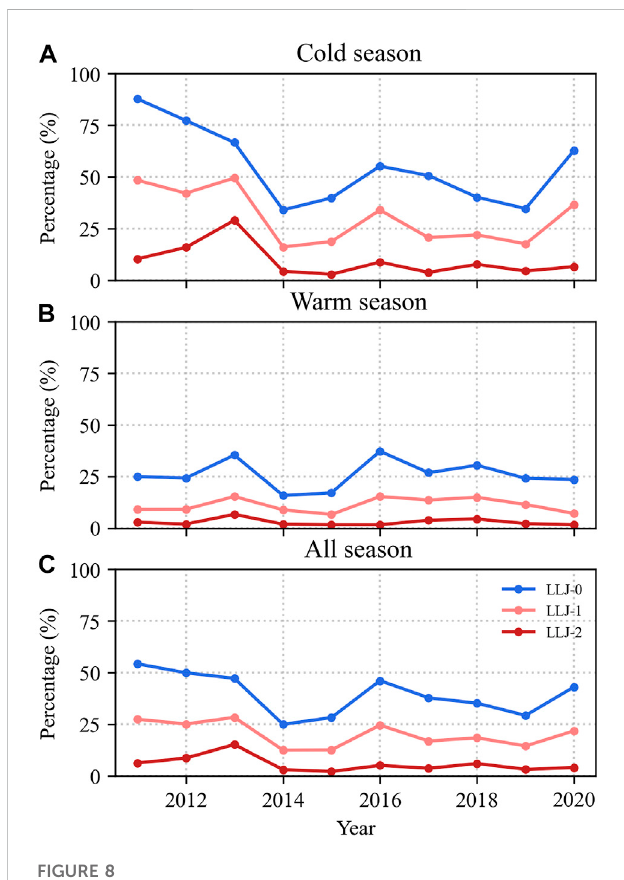
Changes in the frequency of low-level jets. (A) Cold season; (B) Warm season; (C) All